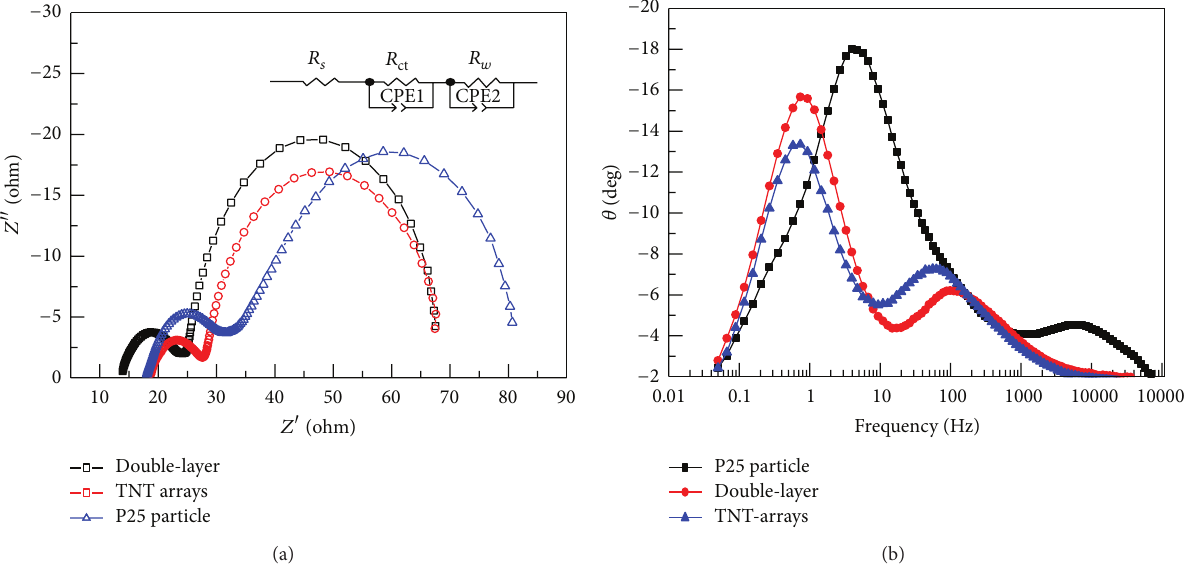
Figure 7: EIS spectra of DSSCs based on double-layer composite film, TNT-arrays film, and P25 nanoparticle film. (a) Nyquist plots and (b) Bode phase